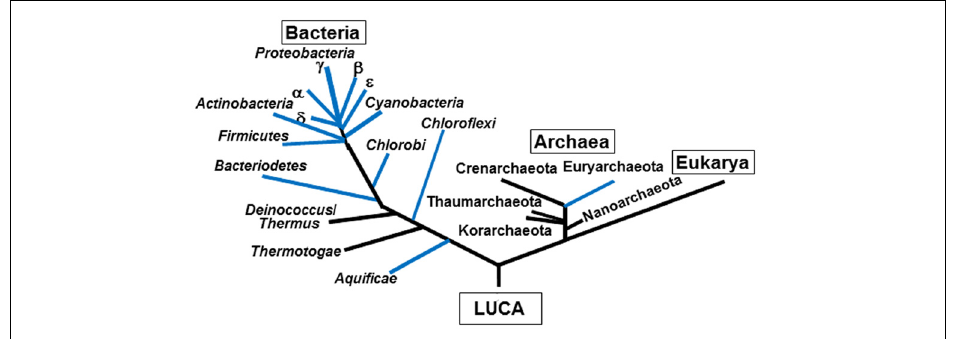
FIGURE 1 | A schematic of a 3 domain taxonomic tree of life with lineages that include nitrogen fixing organisms, as identified through genome screening for nifHDKENB , overlaid in